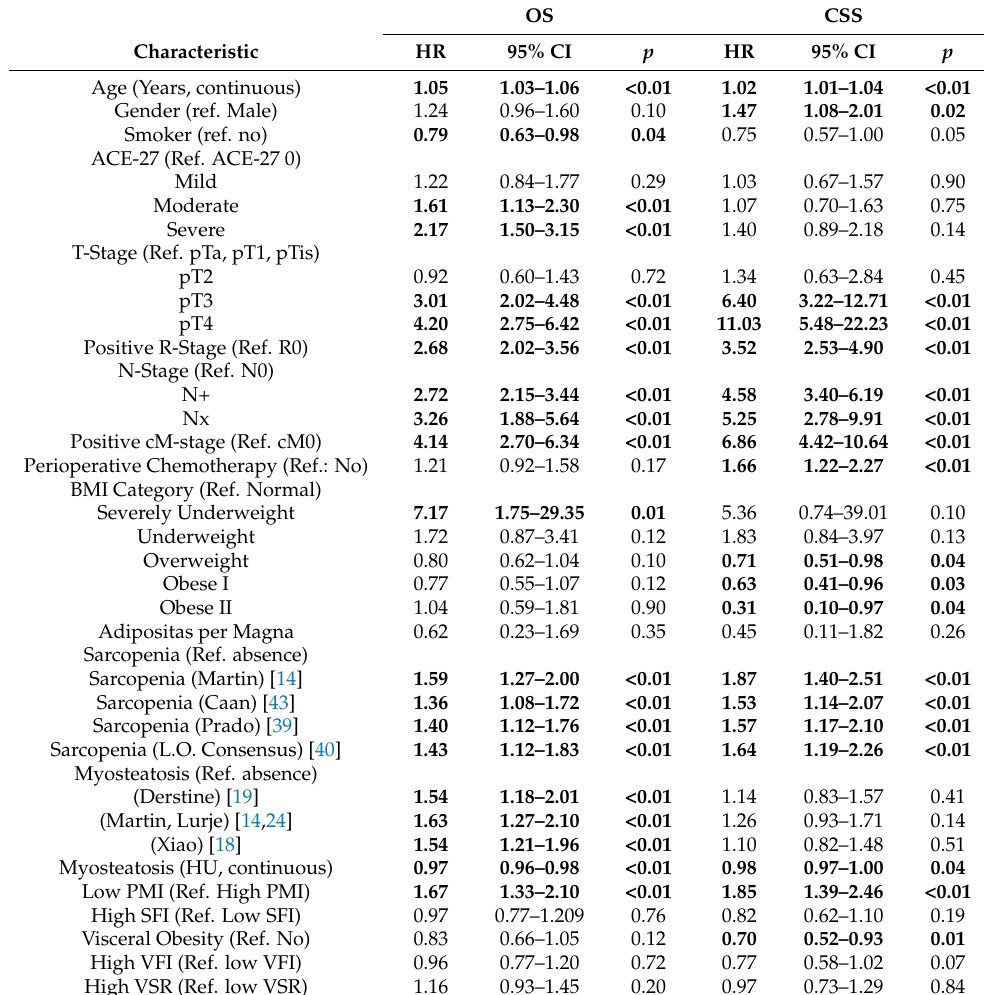
Table 3. Univariate Cox-regression analysis for overall survival and cancer-specific survival in the 657 radical cystectomy patients.